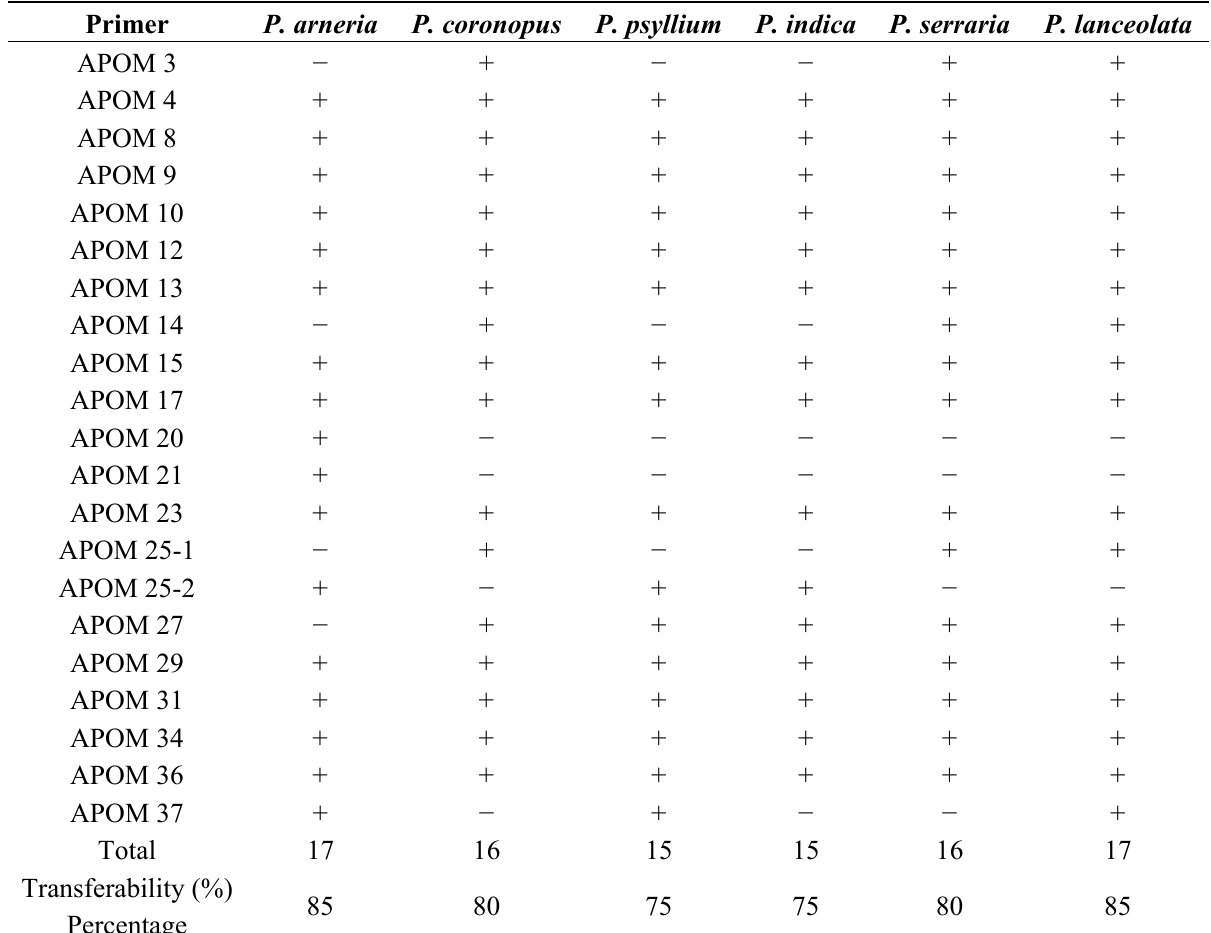
Table 5. SSR cross-amplification in other species of Plantago based on the presence (+)/absence ( − ) of the amplified product.